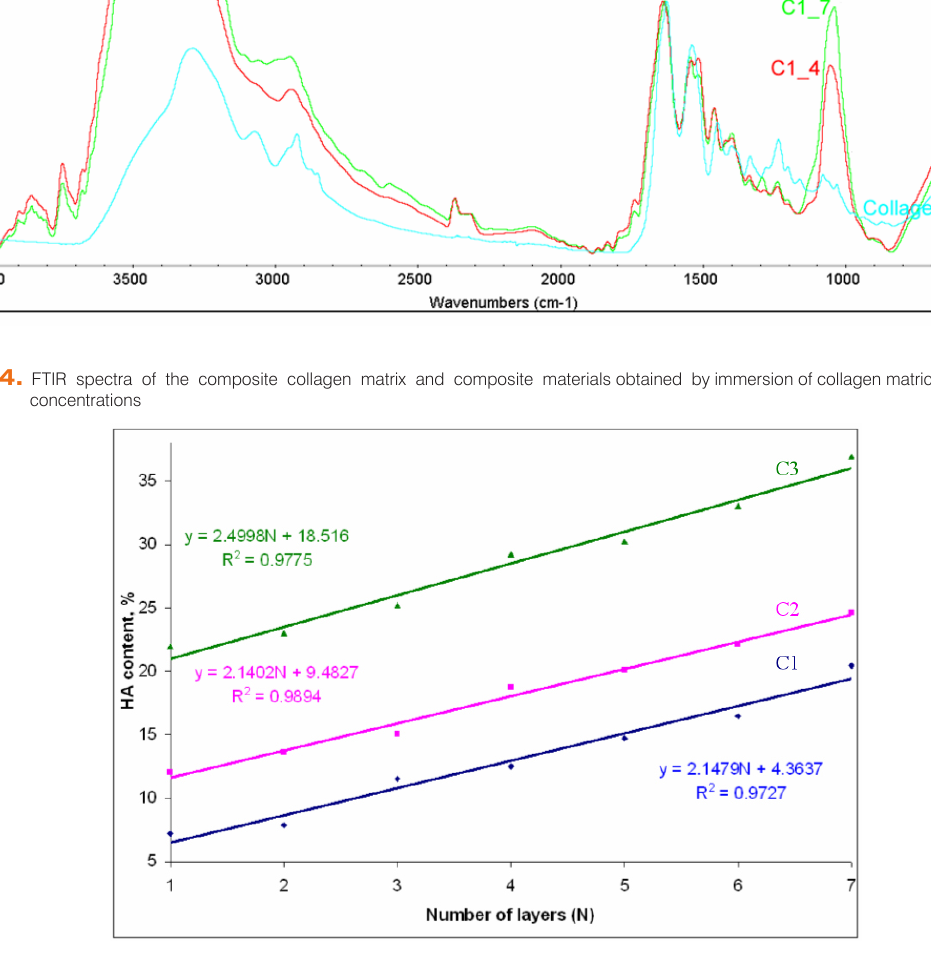
Figure 5. HA content evaluation with the number of layers, determined